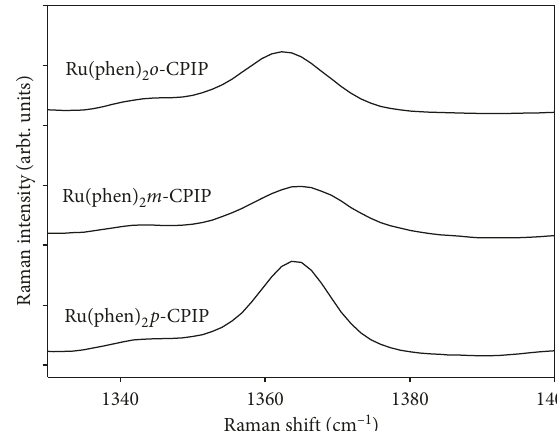
Figure 9: Raman spectra of imidazole ring stretch for the posi- tionally substituted CN.